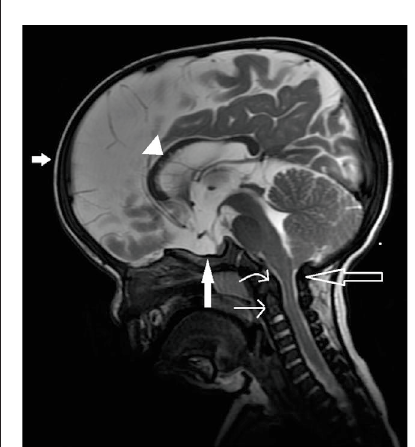
Fig. 1. Sagittal T2 (TR/TE, 3880/109 ms) image shows macrocephaly (small solid arrow) with J-shaped sella (large solid arrow), and dilated perivascular spaces in the corpus callosum (arrowhead). Hypoplastic odontoid process (thin arrow) with thickened ligaments posterior to the odontoid (curved arrow) causing C-V junction stenosis (open arrow) is also noted.